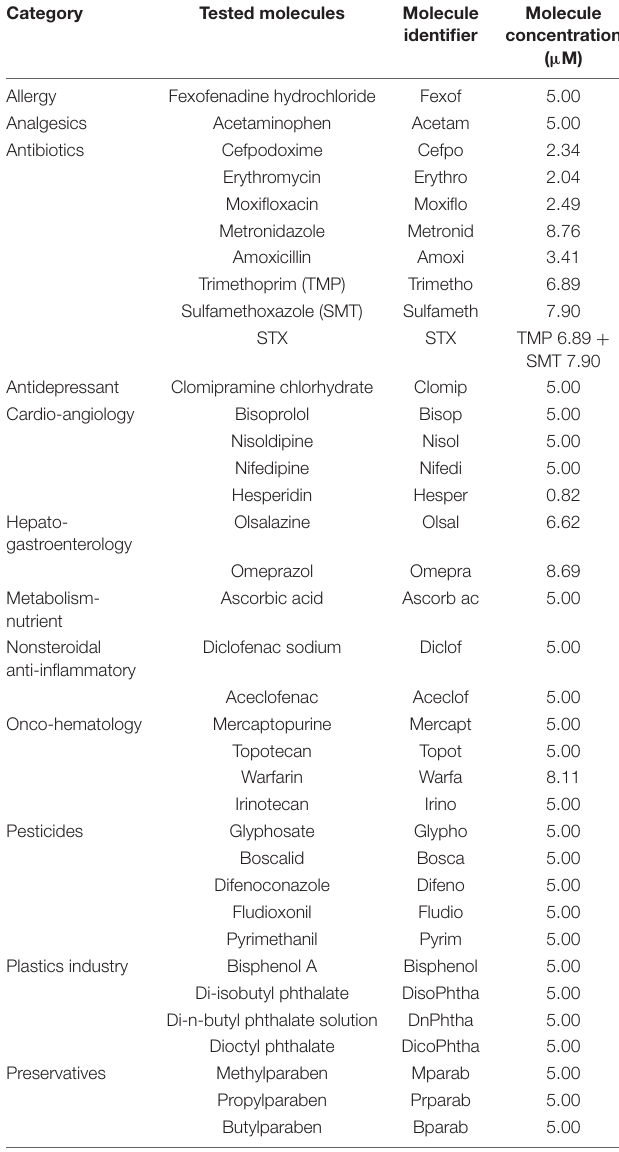
TABLE 2 | Antibiotics, drugs, xenobiotics tested on the HGMM and single strains.